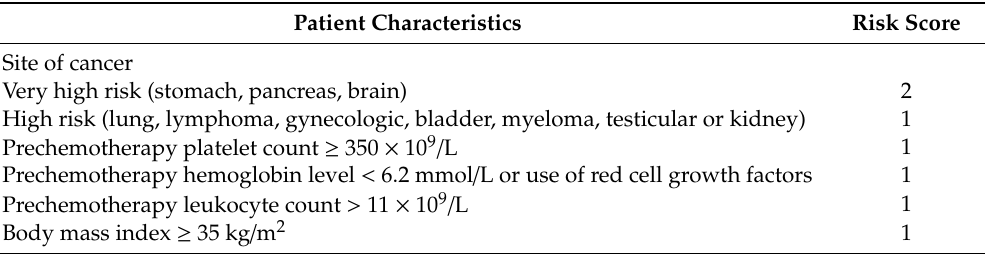
Table 2. Khorana risk